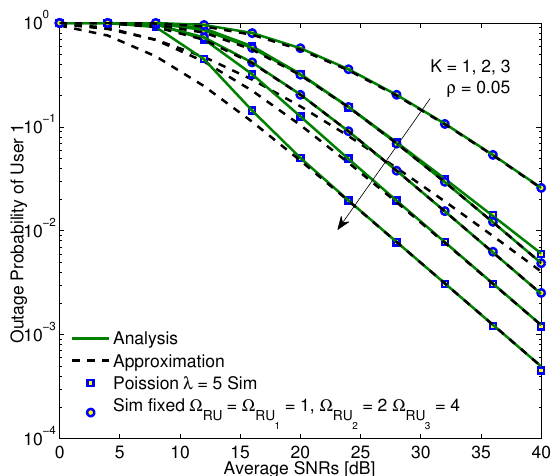
Figure 6. The OP versus SINRs with different numbers of receiving antennas and α = 0.3, η = 0.85, a 1 = 0.6, a 2 = 0.3, a 3 = 0.1.